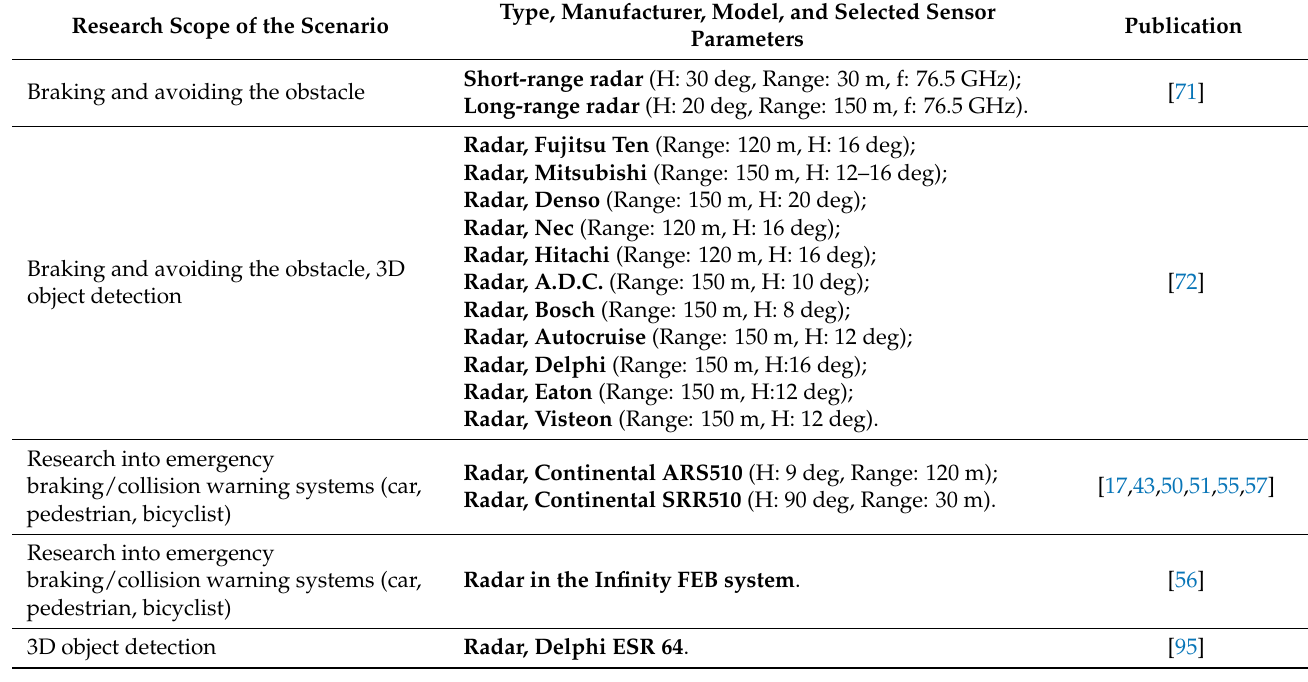
Table 8. Radars used in perception and control systems during AV research. Type, Manufacturer, Model, and Selected Sensor